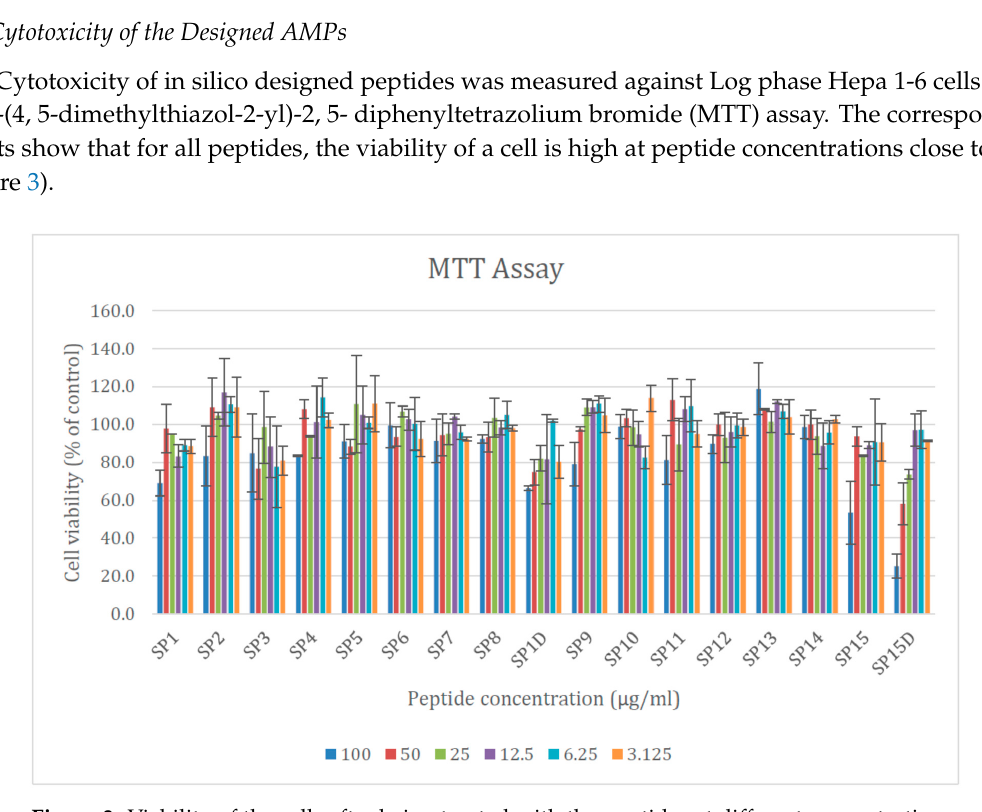
Figure 3. Viability of the cells after being treated with the peptides at different concentrations.